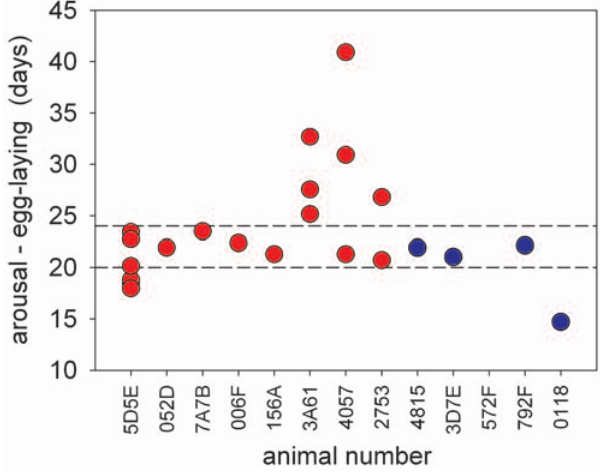
Figure 3. Time between final arousal from hibernation and egg-laying for 23 reproductive events from 13 echidnas, as estimated from internal (red circles), and external (blue circles) temperature loggers. The reported gestation period for echidnas is 20–24 days [15]. Although three animals (3A61, 4057, 2753) were active for periods of up to 3 weeks before becoming pregnant, the majority of points lie between 20 and 24 days after the end of hibernation. In these cases the females must have become pregnant nearly immediately after the final arousal from hibernation, or were already pregnant. Echidna 0118 must have become pregnant during the previous euthermic period (see Figure 2), as was probably also the case for three of 5D5E’s